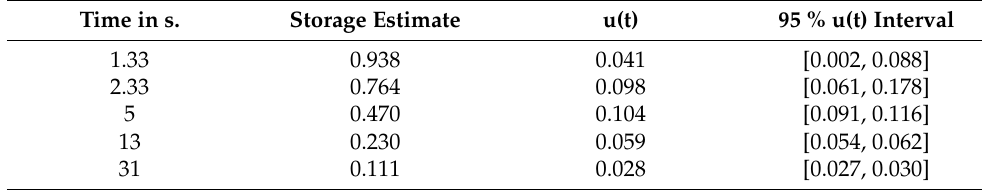
Table 5. Estimates for u ( t ) for data from experiment 3 in [25].